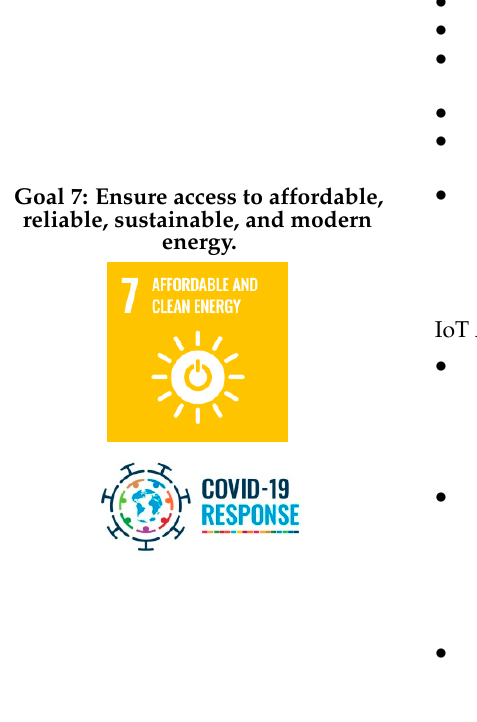
Table 5. Impact of the Sustainable Development Goals on IoT applications for improving health and the environment. SDGs Targets Goals and Application to IoT Systems